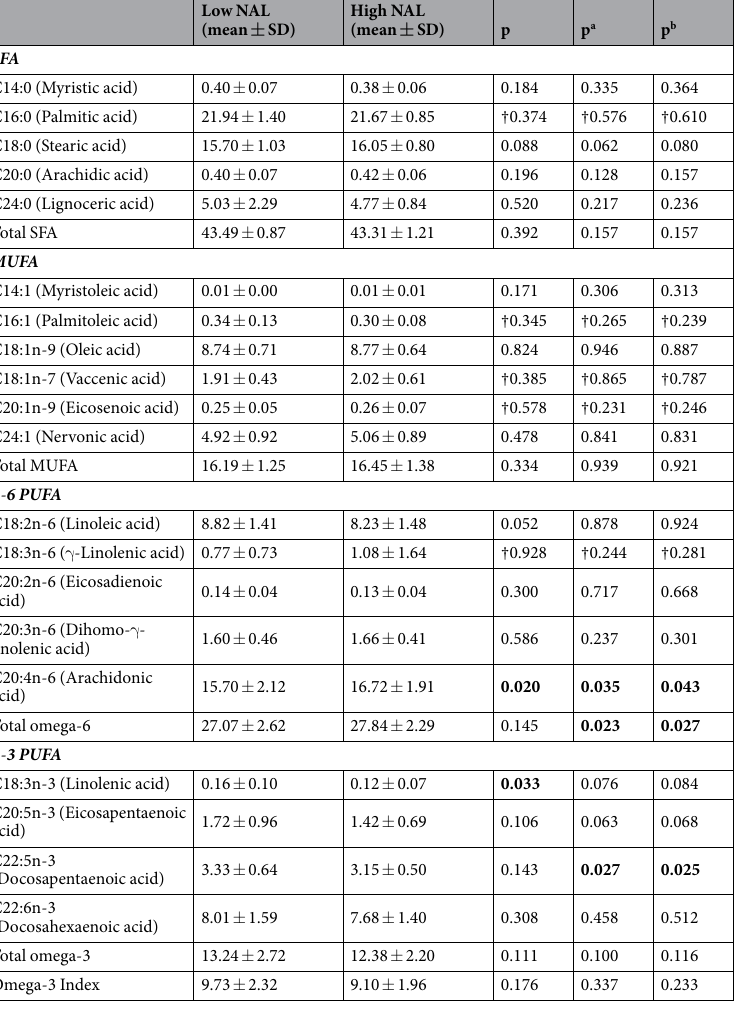
Table 2. Erythrocyte fatty acid concentrations in low and high NAL. Using linear models, fatty acid concentrations were compared between study participants with low (N = 65) and high (N = 35) neocortical amyloid load (NAL) represented by the standard uptake value ratio (SUVR) of the ligand 18 F-Florbetaben in the neocortical region normalised with that in the cerebellum. Low NAL was defined as SUVR < 1.35 while high NAL was defined as SUVR ≥ 1.35. p a indicates p values adjusted for age, gender, years of education and fatty acid supplement intake (cod liver oil, flaxseed oil), hormone replacement therapy. ‘†’ indicates p-values obtained from variables transformed to the logarithmic scale for analyses. SFA: saturated fatty acids;